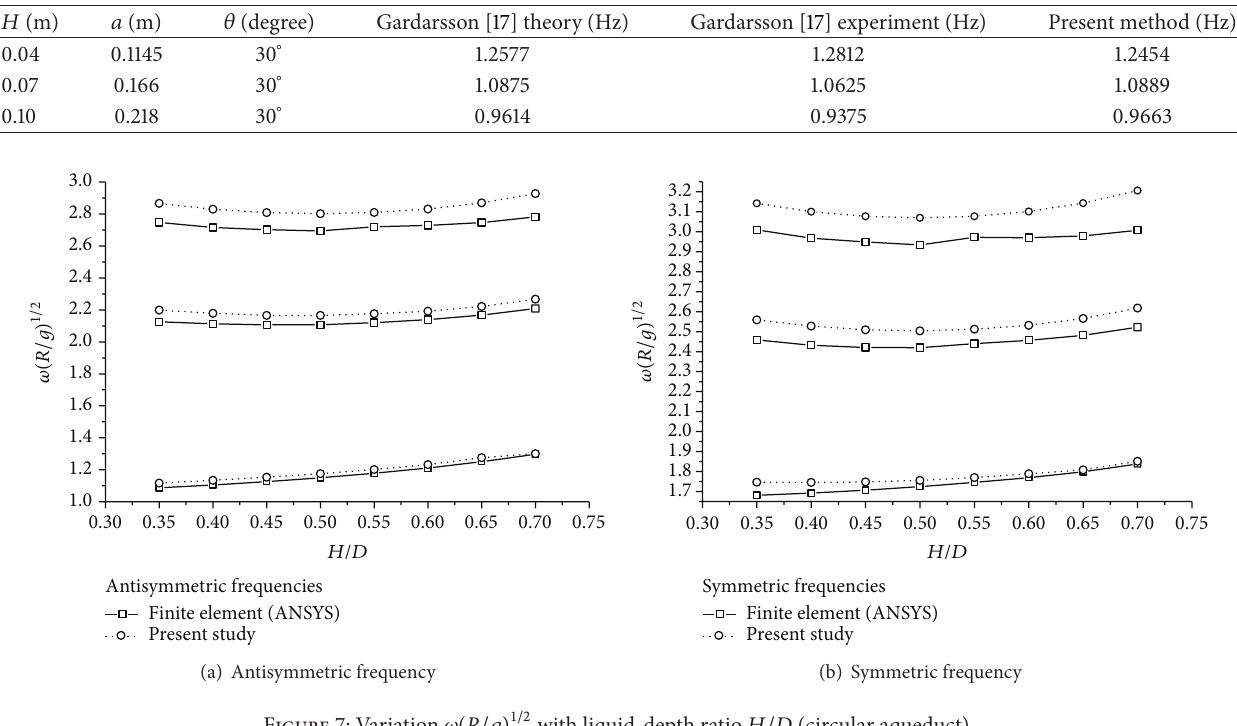
Table 1: Comparison of the fundamental frequencies by Gardarsson [17] and present method.